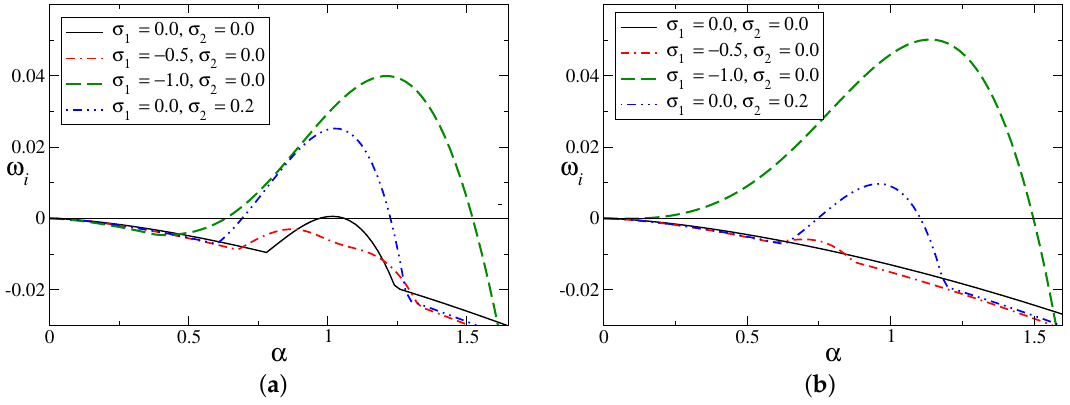
Figure 4. Growth rate ( ω i ) curves for Re = 4000 and different σ 1 and σ 2 : ( a ) β 1 = β 2 = 0 (no slip); and ( b ) β 1 = β 2 = 0.05 (symmetric